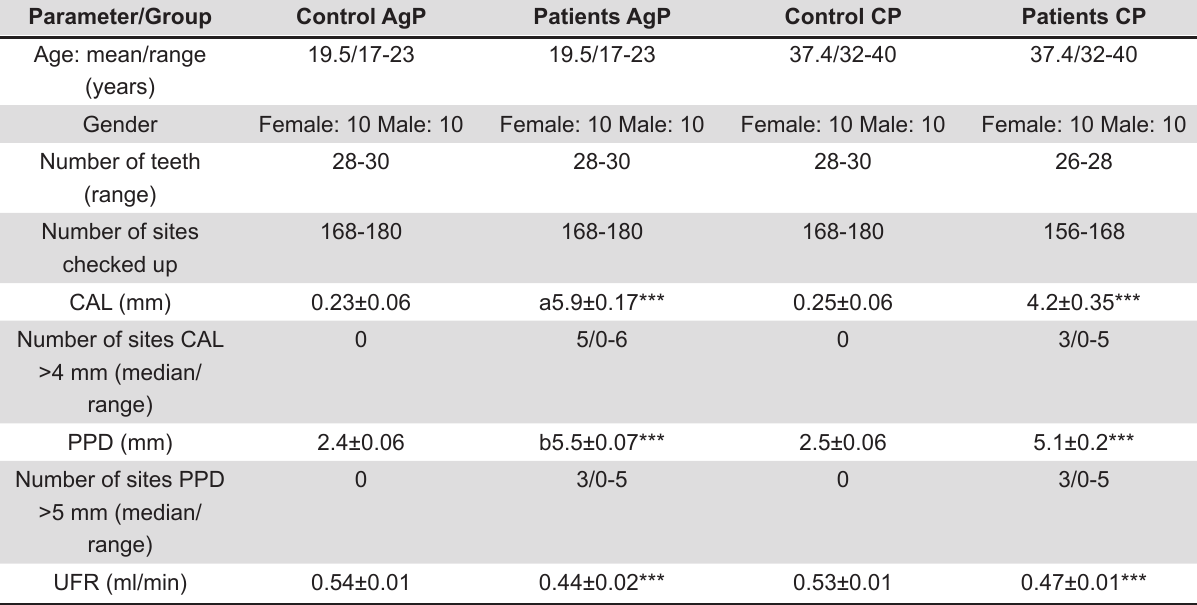
Table 1- Demographic and clinical data from patients with aggressive (AgP) and chronic (CP) periodontitis and their matched